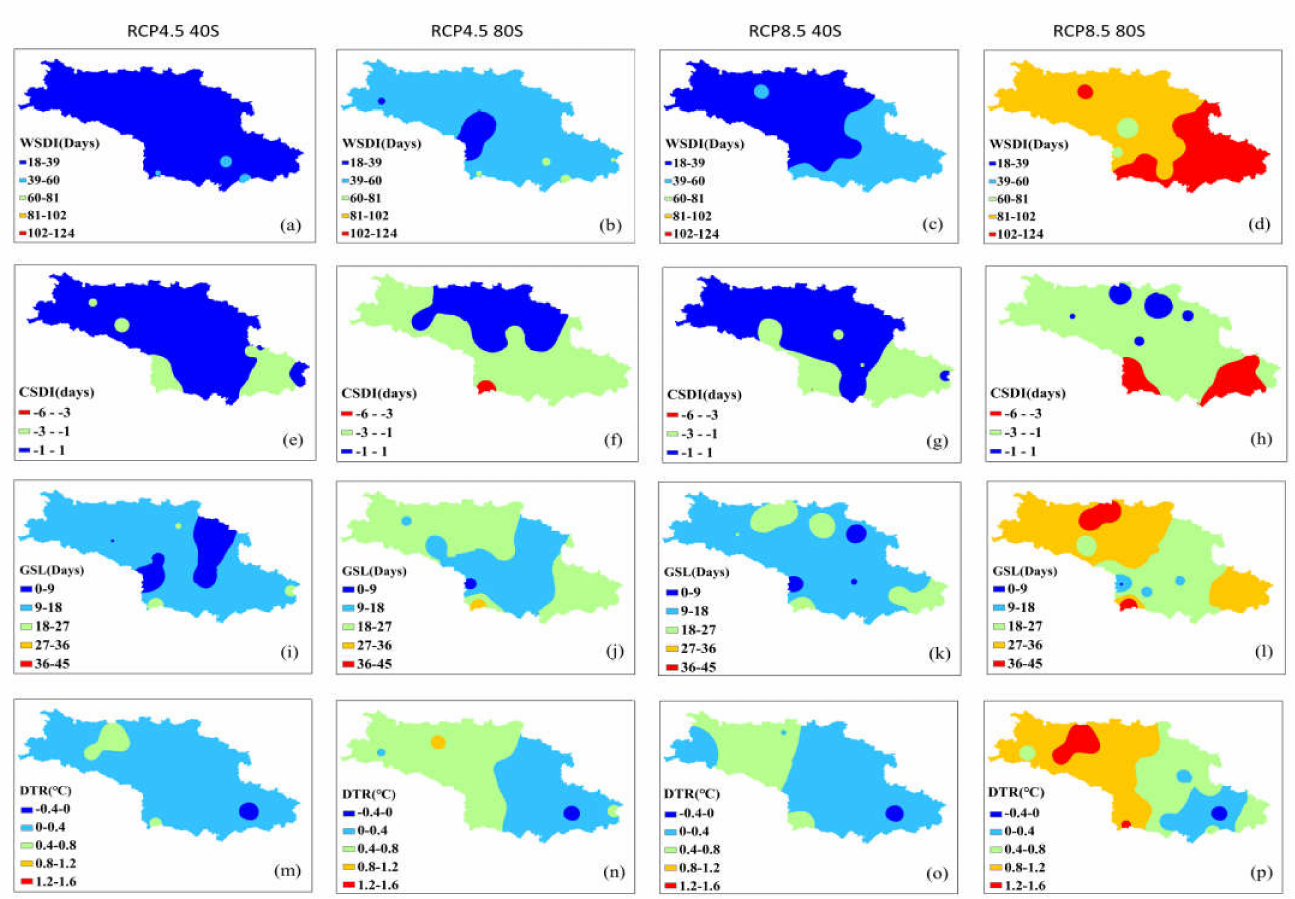
Figure 5. The spatial distribution of changes in the multi-model ensemble for the four spell duration indices (WSDI, a – d ; CSDI, e – h ; GSL, i – l ; DTR m – p ) during the 2040s and 2080s under two scenarios relative to 1971–2010 across the Han River